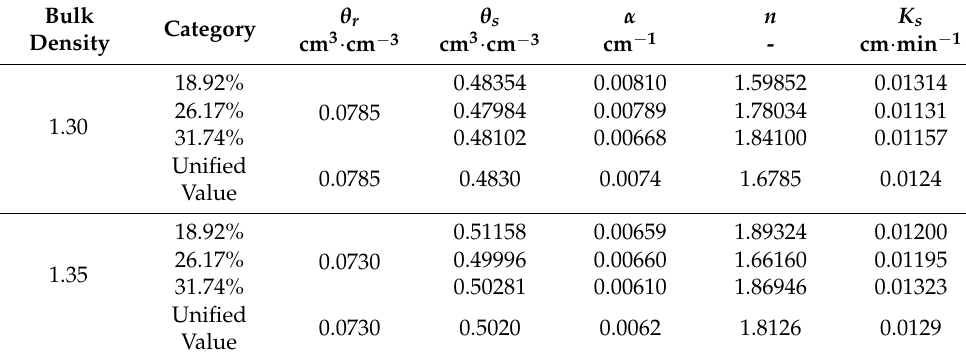
Table 9. Inverse solution results for the sandy loam in laboratory experiments.